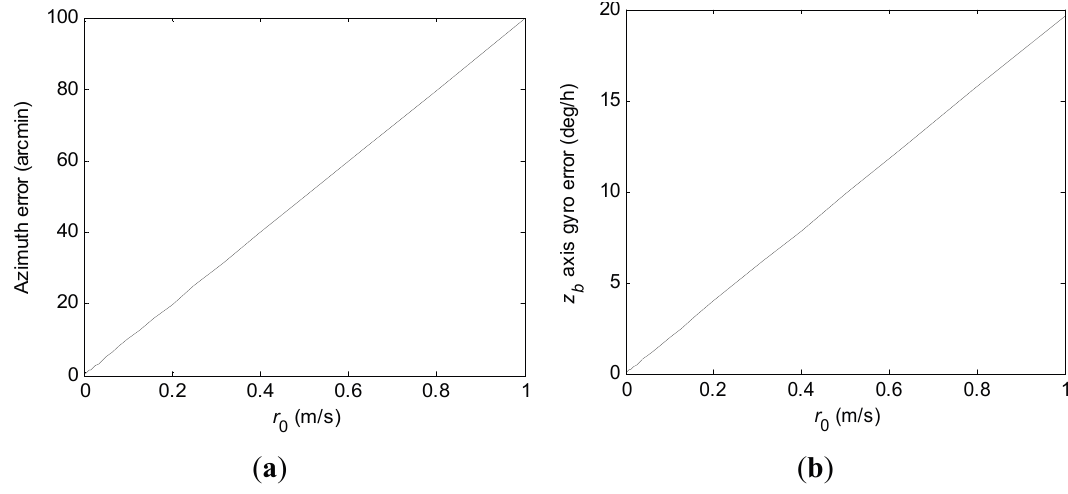
Figure 2. 1- σ values of final azimuth error and final z b axis gyro error at 600 s computed according to r 0 when using the conventional KF scheme. ( a ) Azimuth error; ( b ) z b axis gyro